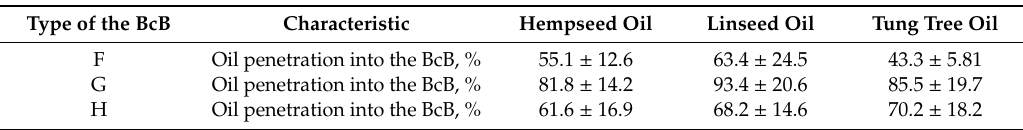
Oil penetration data for di ff erent oil-impregnated biocomposite boards (BcBs) with various